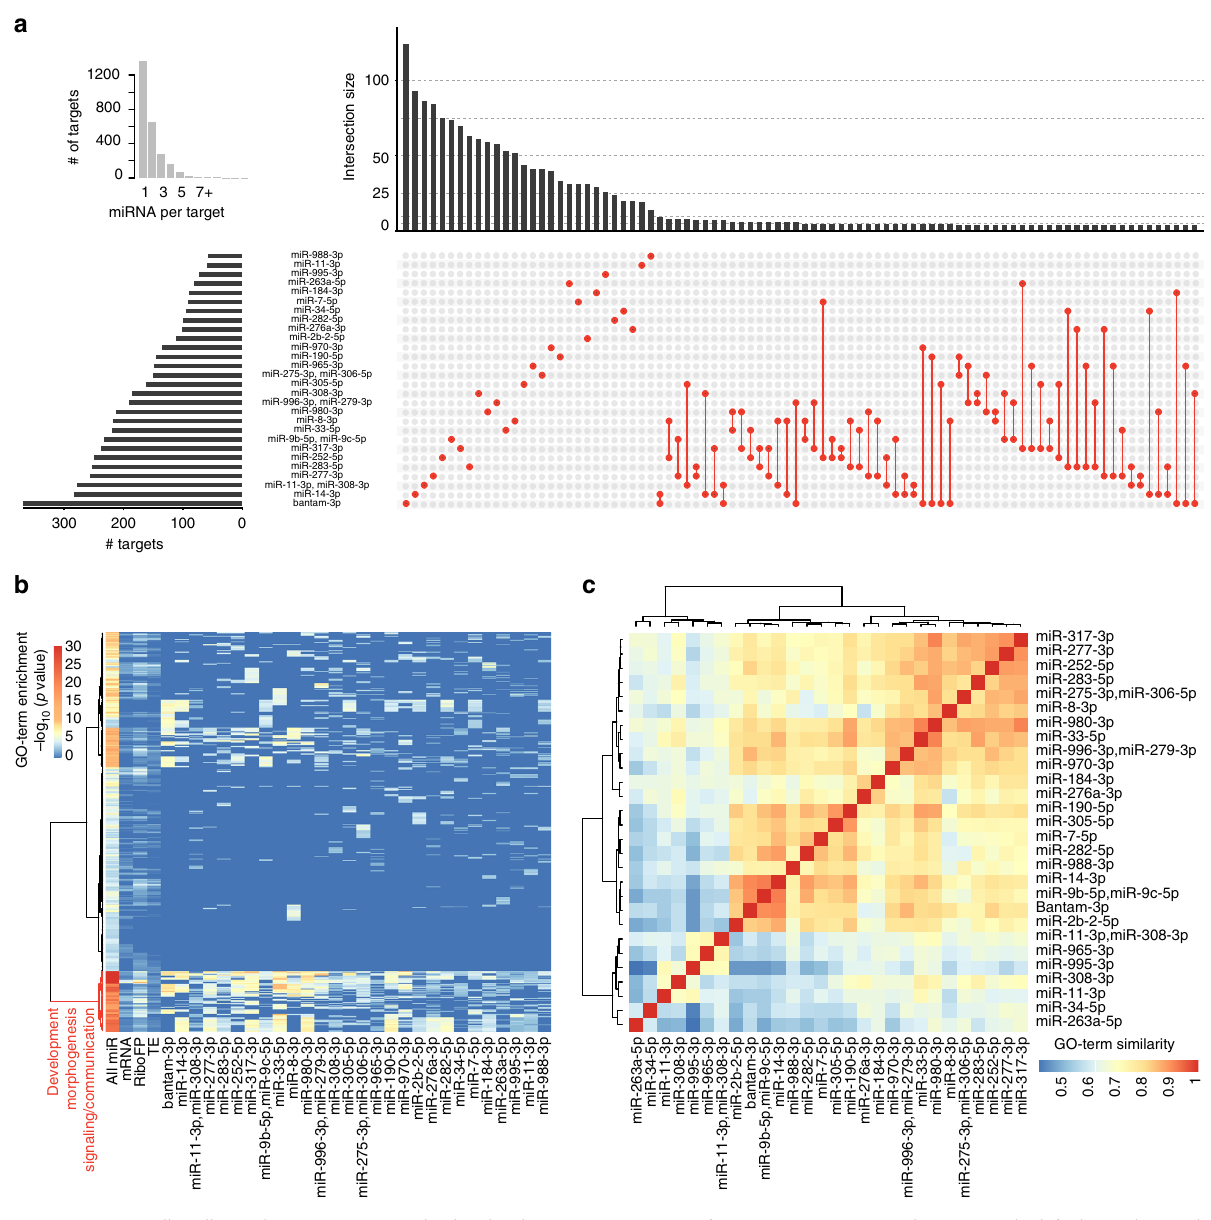
Fig. 5 miRNAs in S2 cells collectively target genes involved in development. a Overview of S2 miRNA targetome. The inset on the left shows the number of detected genes with unique ( = 1) to up to 13 reproducible 3 ′ UTR miRNA binding sites. Upset plot showing all possible miRNA target overlaps with minimally four shared genes ( n = 88 combination > = 4 genes). Barplot on the left indicates the number of all targets per miRNA. The barplot on top indicates the size of the unique target set. The largest target gene sets exist for individual miRNAs. The largest intersect for co-targeting miRNA has a size of nine targets. The sets are indicated by red dots, connected by red lines. b Biological process gene ontology (GOBP) enrichment for all miRNA targets (all miR: n = 2601), top decile of genes upregulated on mRNA level upon AGO1 depletion (mRNA), top decile of genes upregulated on ribosomal footprinting level upon AGO1 depletion (RiboFP), top decile of genes upregulated on translational ef fi ciency level upon AGO1 depletion (TE; each n = 597), and all individual miRNA target sets, relative to all genes considered during functional analysis previously ( n = 5963). All signi fi cantly enriched ( p < 0.001; Fisher ’ s exact test; n = 501) GO terms for all miRNA targets were selected, merged to the corresponding enrichments in all other sets, and row-wise clustered (distance = maximum, clustering function = ward) after p value − log10-transformation, resulting in two main clusters. miRNAs are sorted by the number of targets. We did not observe enriched GO terms for individual miRNA target sets, which were not already covered by enrichments in all miR (Supplementary Data 14). c Pair-wise GO-term similarities using GOSemSim, for the top 100 enriched GOBP terms given p < 0.001 (Fisher ’ s exact test), and clustered (distance = euclidean, clustering =